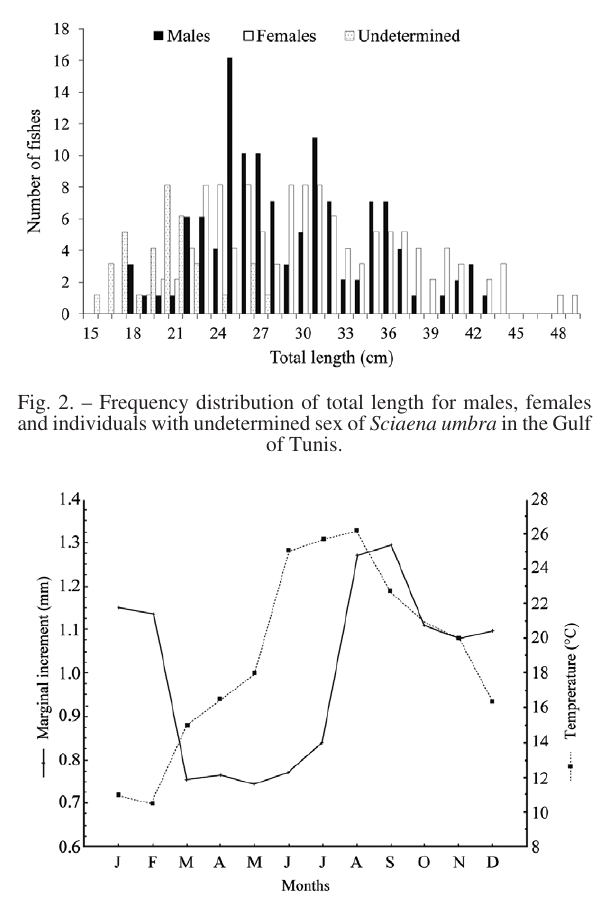
Fig. 3. – Monthly evolution of average marginal increment of Sciae- na umbra in the Gulf of Tunis and the associated sea surface mean temperature (spawning period: May, June and July).